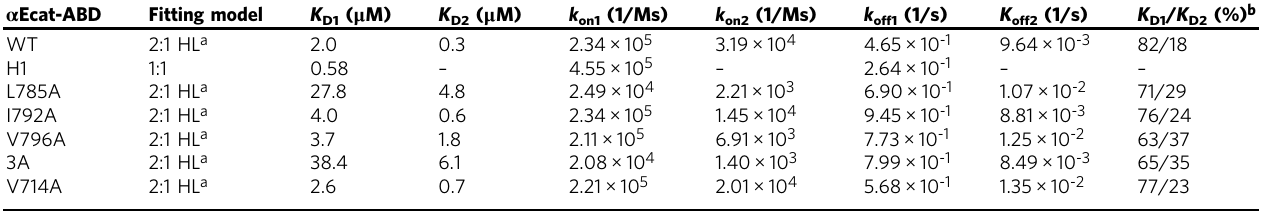
a 2:1 heterogeneous ligand (HL) model provides two sets of kinetics parameters ( k on1 , k off1 , K D1 ) and ( k on2 , k off2 , K D2 ) b The percentage of two kinetic interactions in the total binding was determined based on R max